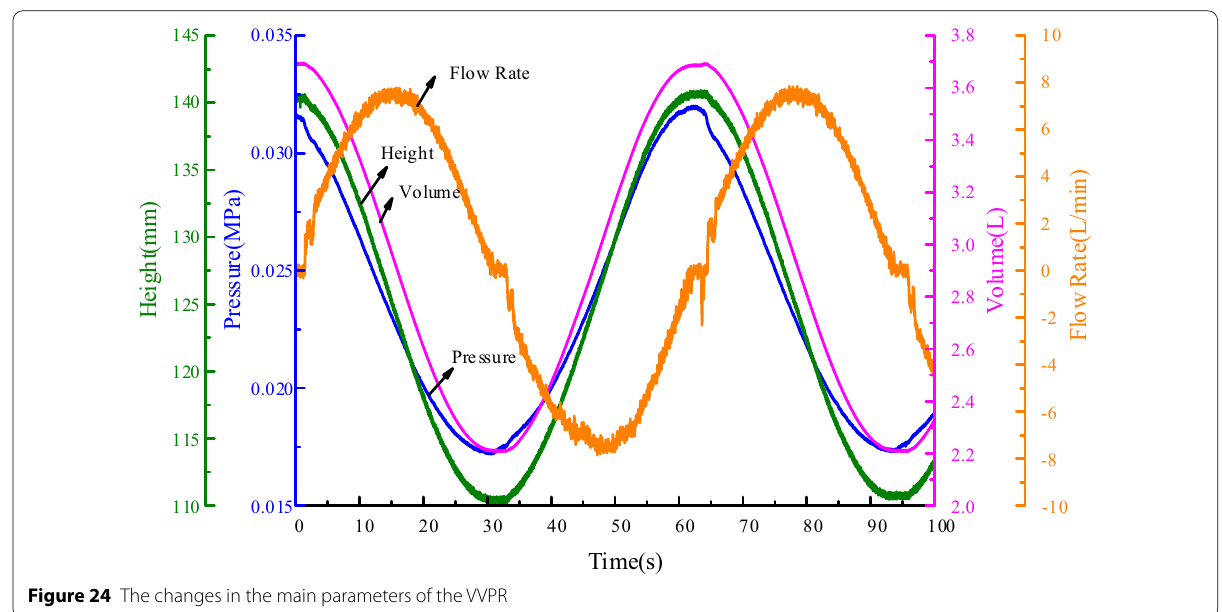
Figure 24 The changes in the main parameters of the VVPR